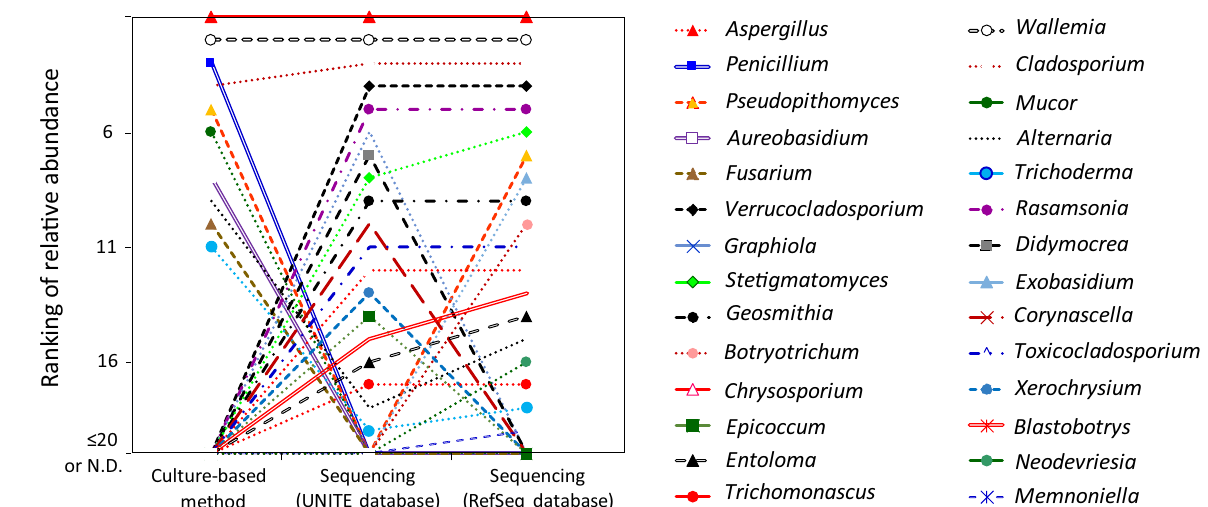
Figure 2. Rankings of averaged relative abundances of major fungal genus.